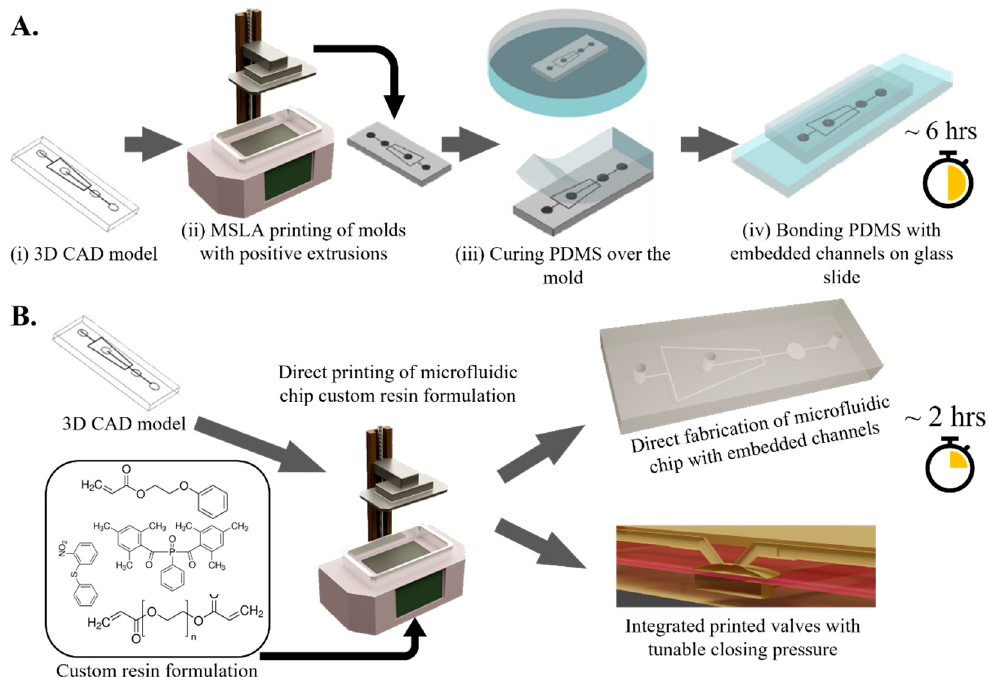
Figure 1. ( A ). PDMS microfluidic chips developed with 3D printed positive molds. Fabrication steps include (i) developing a 3D CAD model of the positive mold, (ii) stereo-lithographically printing and curing the positive molds, (iii) casting and curing PDMS over the positive molds and (iv) plasma assisted bonding of the cured PDMS with embedded channels onto a glass slide. ( B ). Incorporation